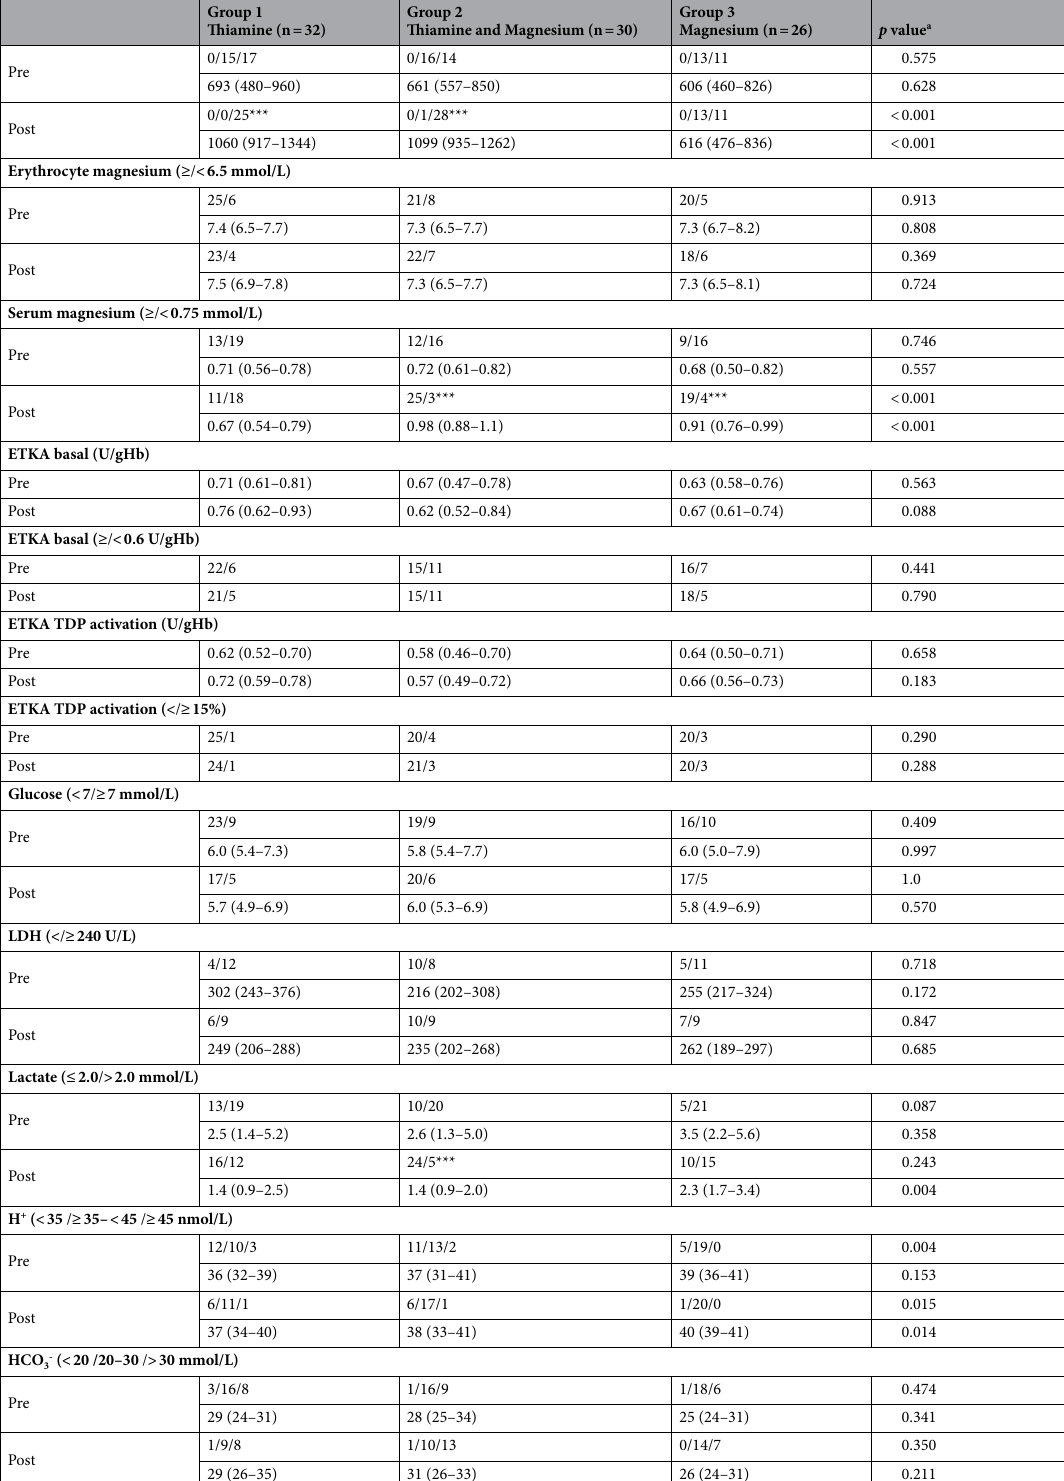
Table 2. (a) Pre- and post- treatment laboratory results for randomisation groups (n = 115), (b) Sensitivity analysis: Pre- and post- treatment laboratory results according to randomisation groups for patients receiving long-term treatment with oral thiamine supplementation prior to recruitment (n = 88). a Categorical and continuous data were analysed with Chi-squared and Kruksall-Wallis tests respectively. *,**Changes between pre- and post- treatment measurements with significance p < 0.01 and p < 0.001 respectively as calculated by Wilcoxon Signed Ranks test. ***Changes between pre- and post- treatment measurements with significance p < 0.001 as calculated by Wilcoxon Signed Ranks